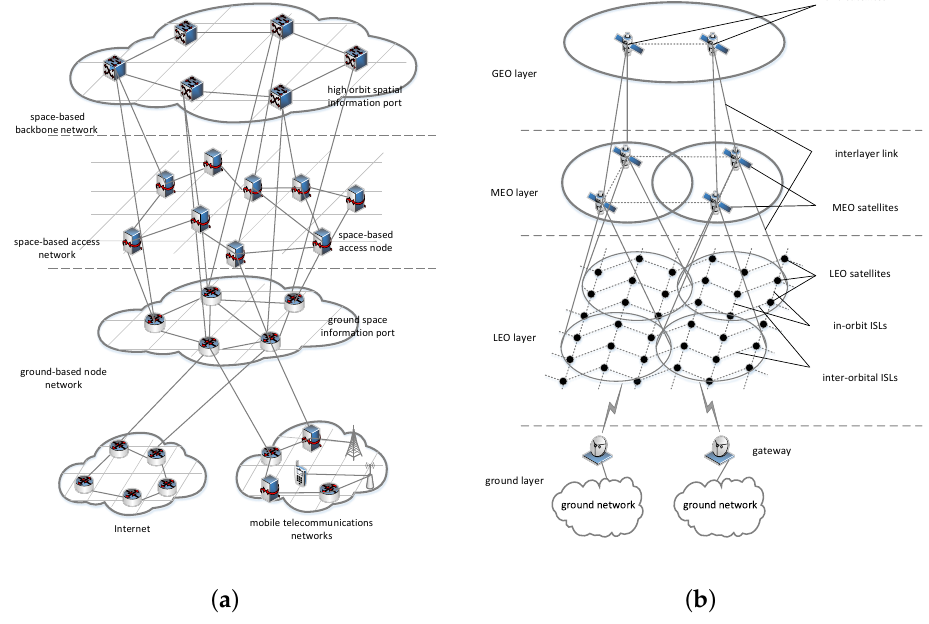
Figure 1. Networking structure of Space Information Networks. ( a ) is architecture of space informa- tion network. ( b ) is topological structure of space information